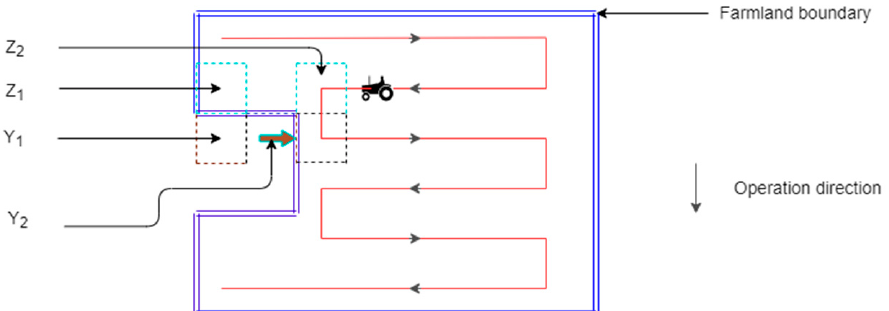
Figure 6. U-turn dead zone judgment diagram. Y 1 is the grid on the same side as the working direction; Y 2 is the detection direction on the same side as the working direction; Z 1 is the original turn; and Z 2 is the actual turn. If the U-turn dead zone judgment is not performed, the robot stops seeding at Z 1 and turns around to enter the U-turn dead zone. After making a U-turn dead zone judgment, the robot stops seeding at Z 2 and completes the U-turn to avoid entering the U-turn dead zone.